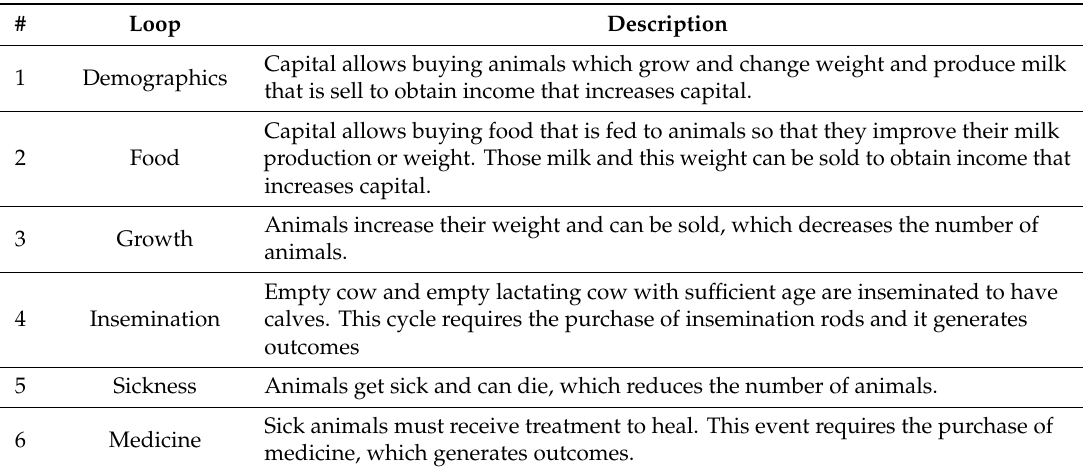
Table 2. Feedback loops in the causal loop diagram